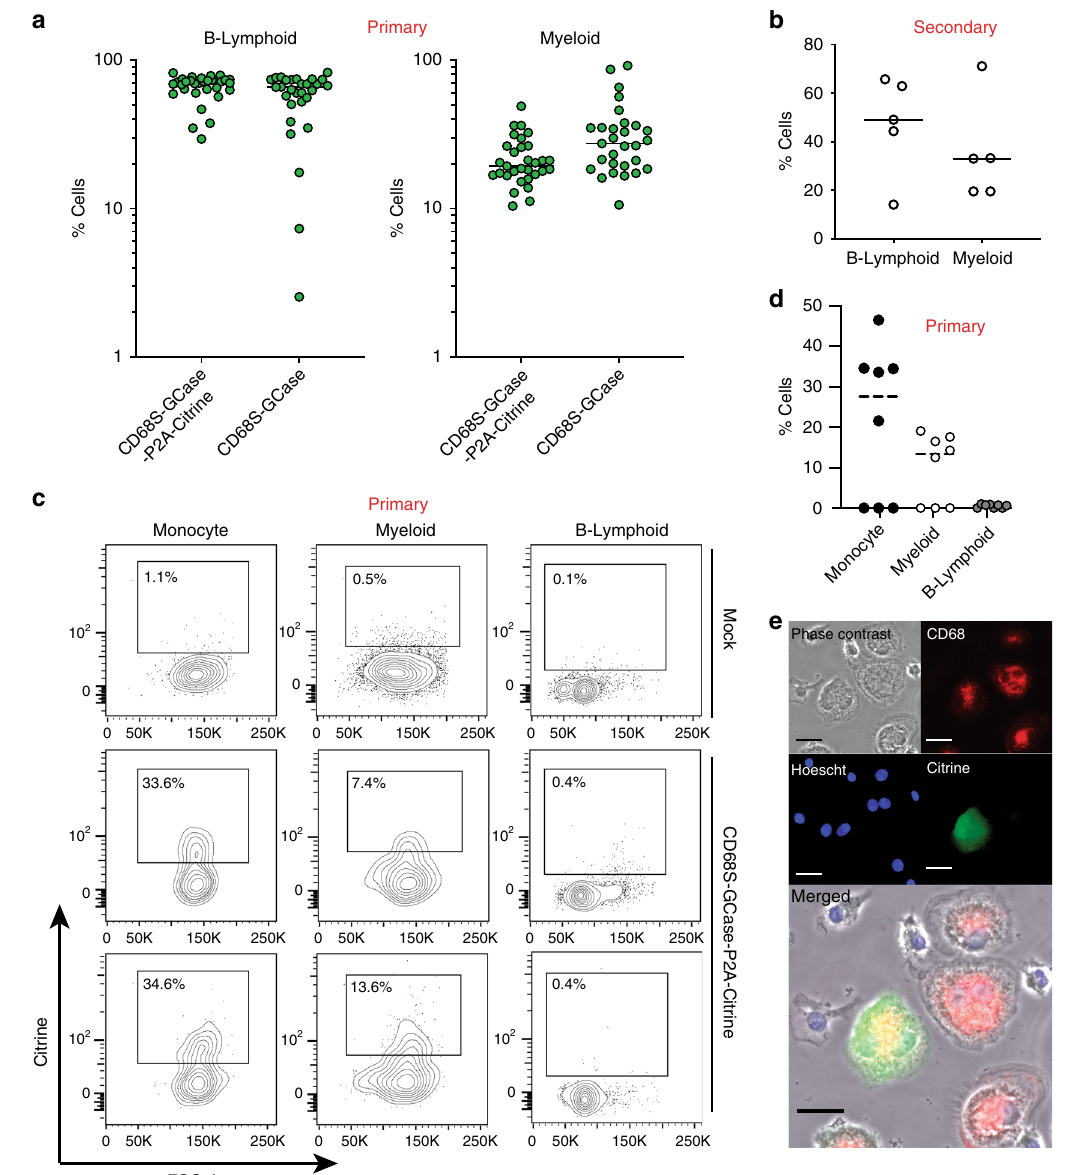
Fig. 5 In vivo monocyte/macrophage lineage differentiation of GCase-targeted HSPCs. a Distribution of B-lymphoid and myeloid lineage cells within the engrafted human cell population in the bone marrow from mice transplanted with CD68S-GCase and CD68S-GCase-P2A-Citrine-targeted HSPCs ( n = 29, 31 mice). b Distribution of B-lymphoid and lineage cells within the engrafted human cell population from secondary transplants. Empty: vector without Citrine ( n = 5 mice). c Representative FACS plots showing Citrine expression in human CD33 + (Myeloid), CD14 + (Monocyte) and CD19 (B-cells). d Percent Citrine-positive cells in monocyte (black), myeloid (white), and B-cell (gray) populations in mice with human CCR5 allele modi fi cation fraction >10%. e Representative epi fl uorescence microscopy images of human CD68S-GCase-P2A-Citrine-targeted macrophages differentiated from human CD14 + cells sorted from mice bone marrow and peripheral blood ( n = 10 mice, additional examples in Supplementary Fig. 8). Images depict morphology (bright fi eld), nuclei (Hoechst, blue), CD68 protein (red), and Citrine (green). Scale bar is 10 µ m. a , b , d Median shown. Source data are provided as a Source Data fi